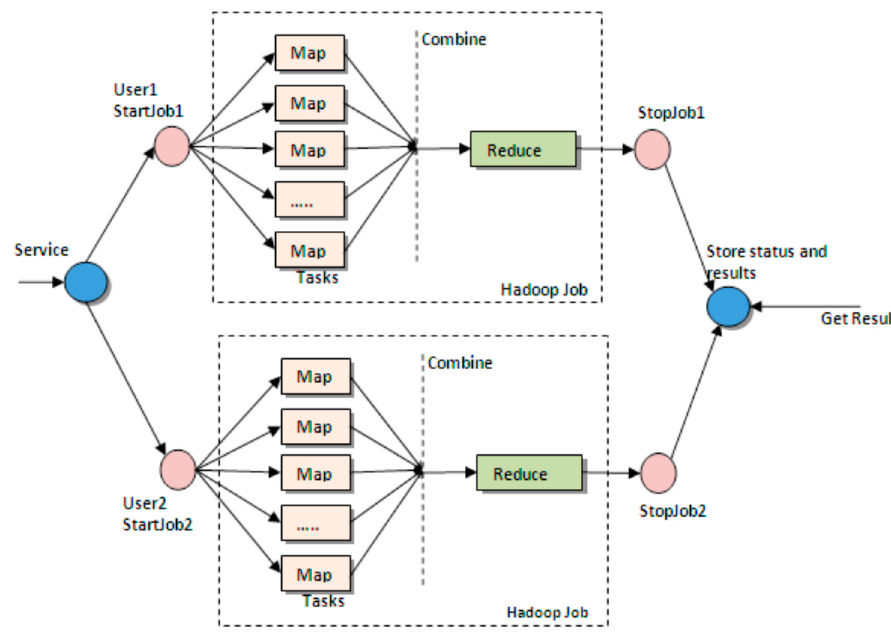
Figure 2. The Map/Reduce paradigm.